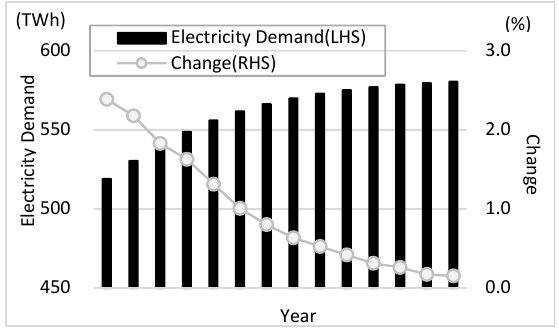
Figure 3. Electricity demand and growth rate for rLCOE in Korea.